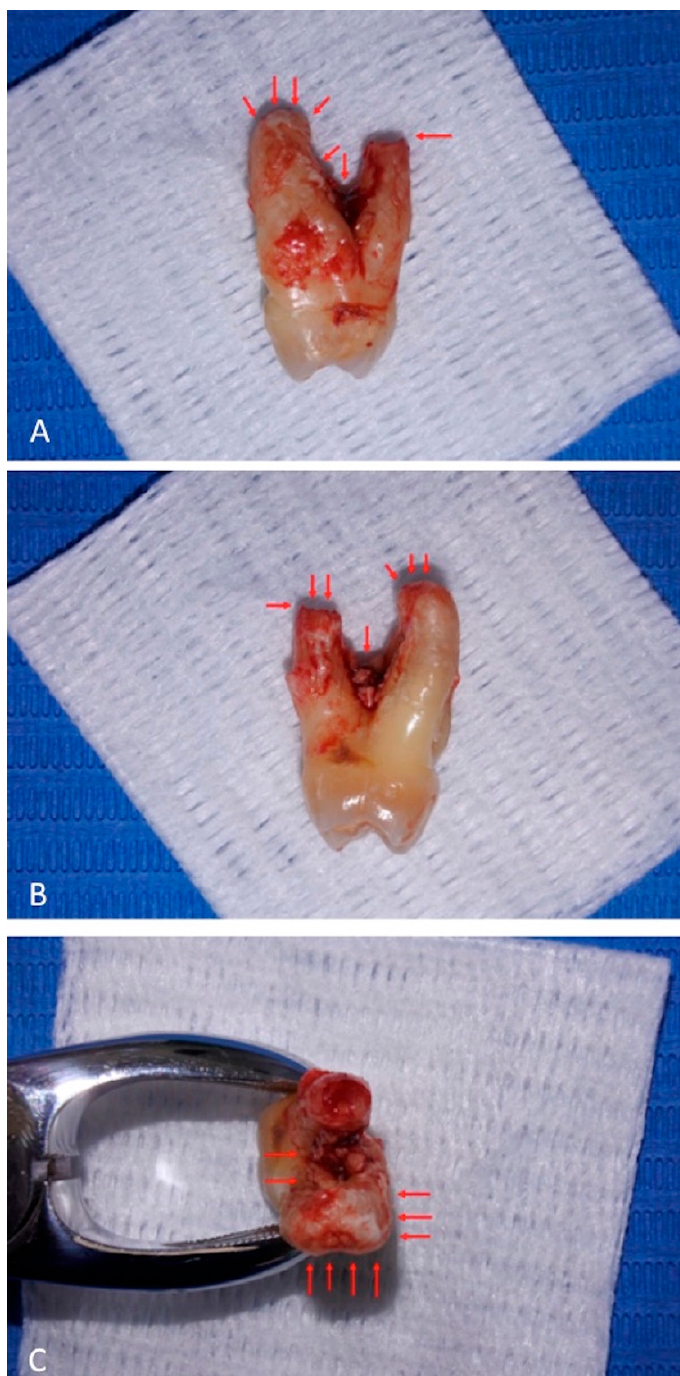
Figure 3. Decay or leakages are not appreciable on tooth crown surface. Root surfaces present adherent granulation tissue. The palatal root, on the right (panel A ) and on the left (panel B ) views, presents apical horizontal resorption. Root furcation shows adherent granulation tissue and biofilms. On the top view (panel C ), apical resorption of the palatal root is evident (upper side), and adherent granulation tissue reaches the apical region of the vestibular root (lower side). Red arrows indicate the lesions.